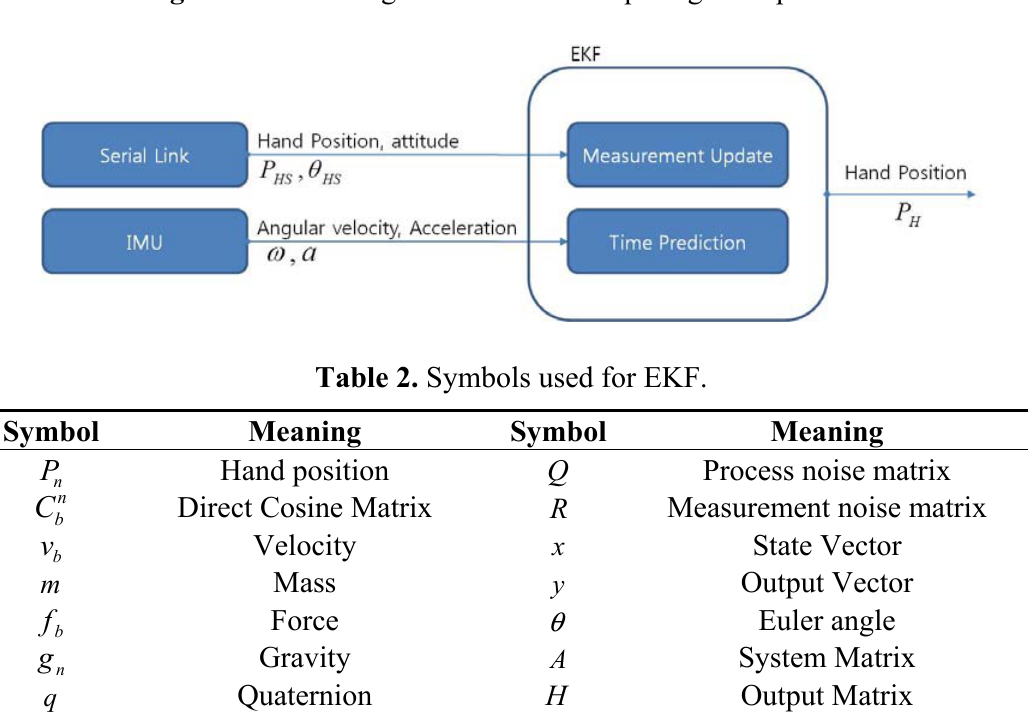
Figure 4. Block diagram of EKF for acquiring hand position.